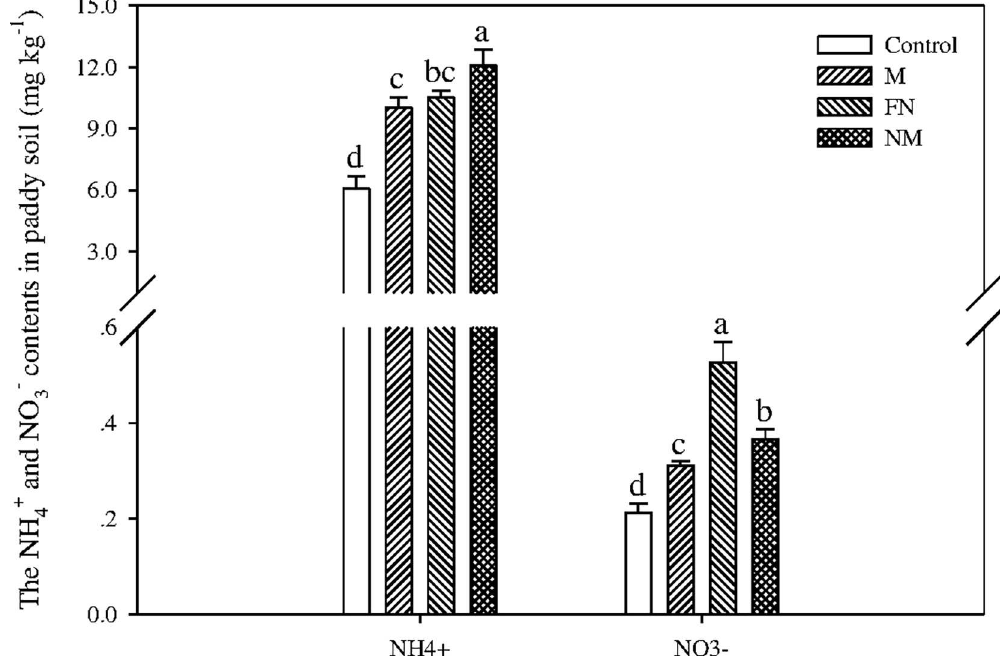
Fig 3. Effects of CMV as GM on the NO 3- and NH 4+ contents in paddy soil at maturity stage of rice plants. Bars indicatestandard error (n = 3). Different letters indicatesignificantly different means at P <